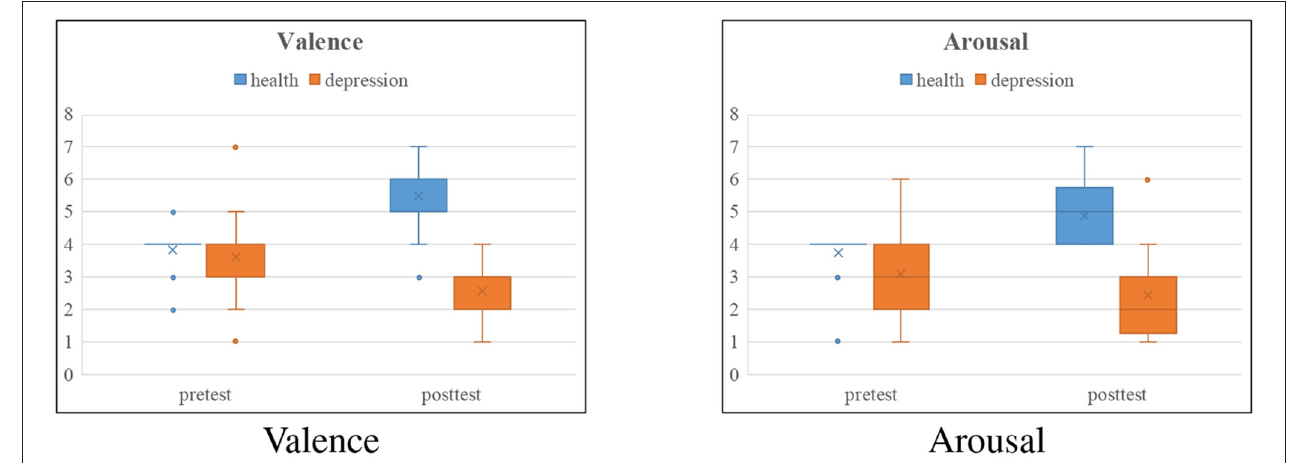
FIGURE 8 | Box comparison charts of the valence and arousal of the healthy group and depressed group before and after positive film clips stimulation.